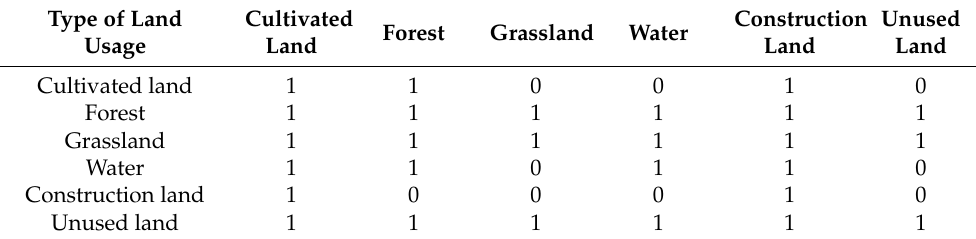
Table 3. Budget matrix for ecological conservation